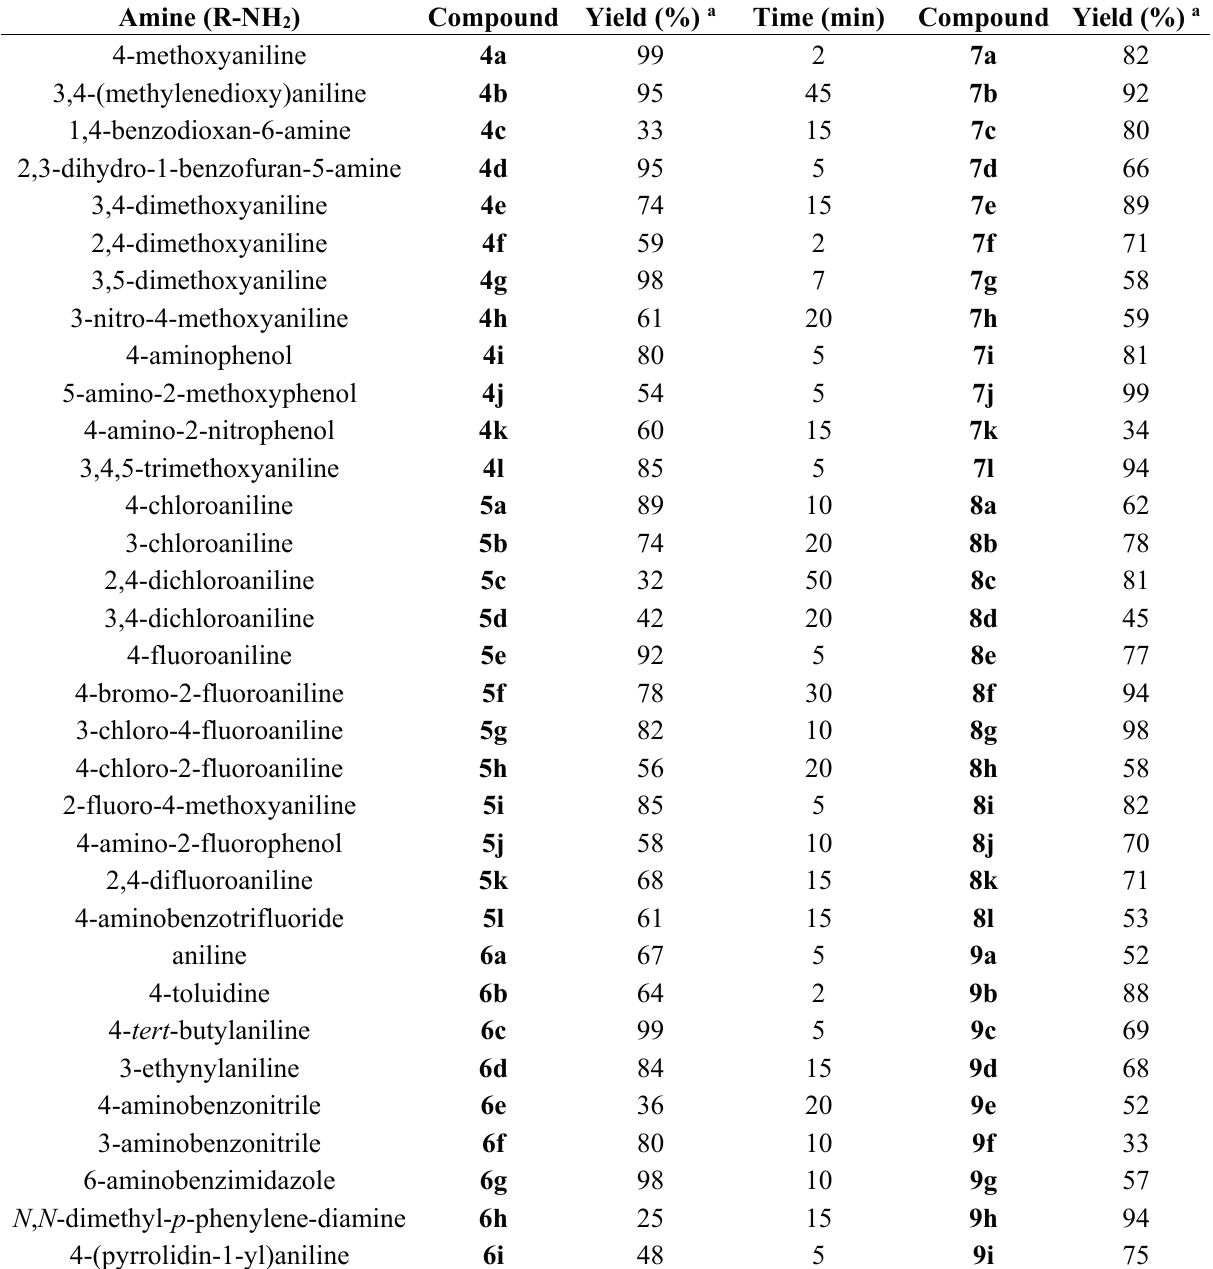
Table 1. Synthesis of carbonitrile 4 – 6 and their corresponding methyl carbimidates 7 – 9